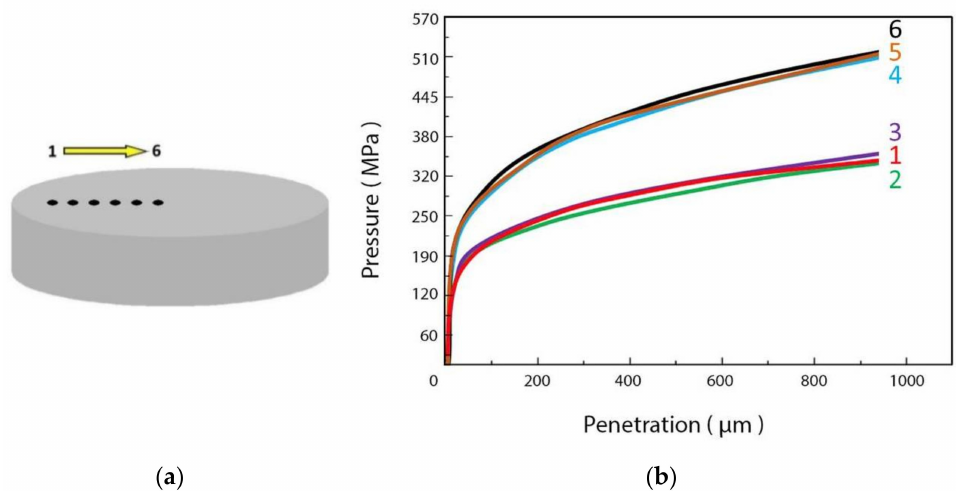
Figure 6. Schematic view of a section of an aluminium billet where FIMEC tests were performed in different positions along the radial direction ( a ). The pressure–penetration depth curves are displayed in ( b